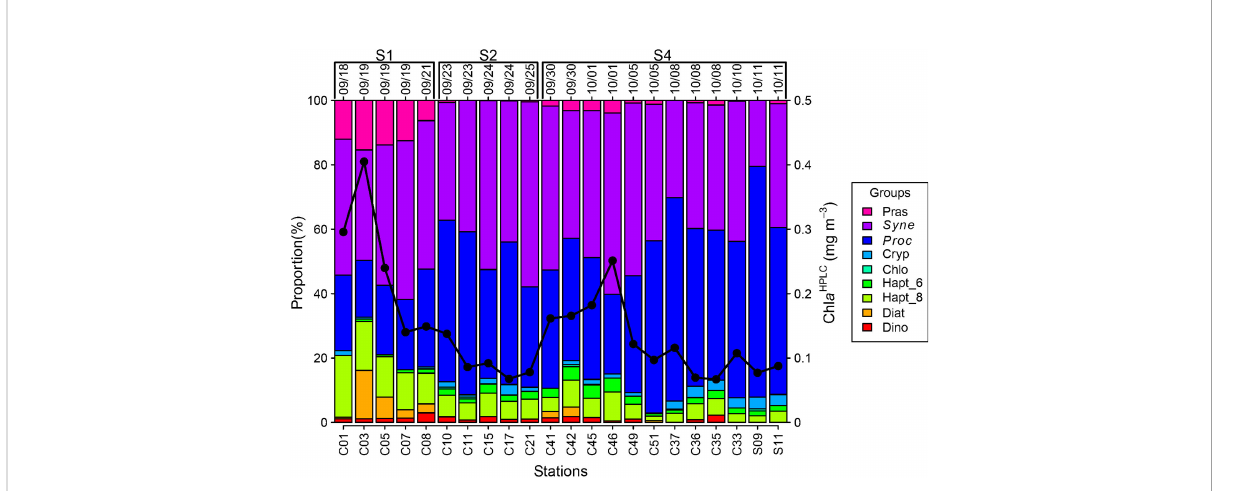
FIGURE 4 The concentration of total Chl a (Chl a HPLC ) and contributions of different phytoplankton groups during the cruise. Dino, Diat, Hap_8, Hap_6, Chlo, Cryp, Proc , Syne , and Pras are the abbreviations for Dino fl agellates, Diatoms, Haptophytes (type 8), Haptophytes (type 6), Chlorophytes, Cryptophytes, Synechococcus , Prochlorococcus , and Prasinophytes.